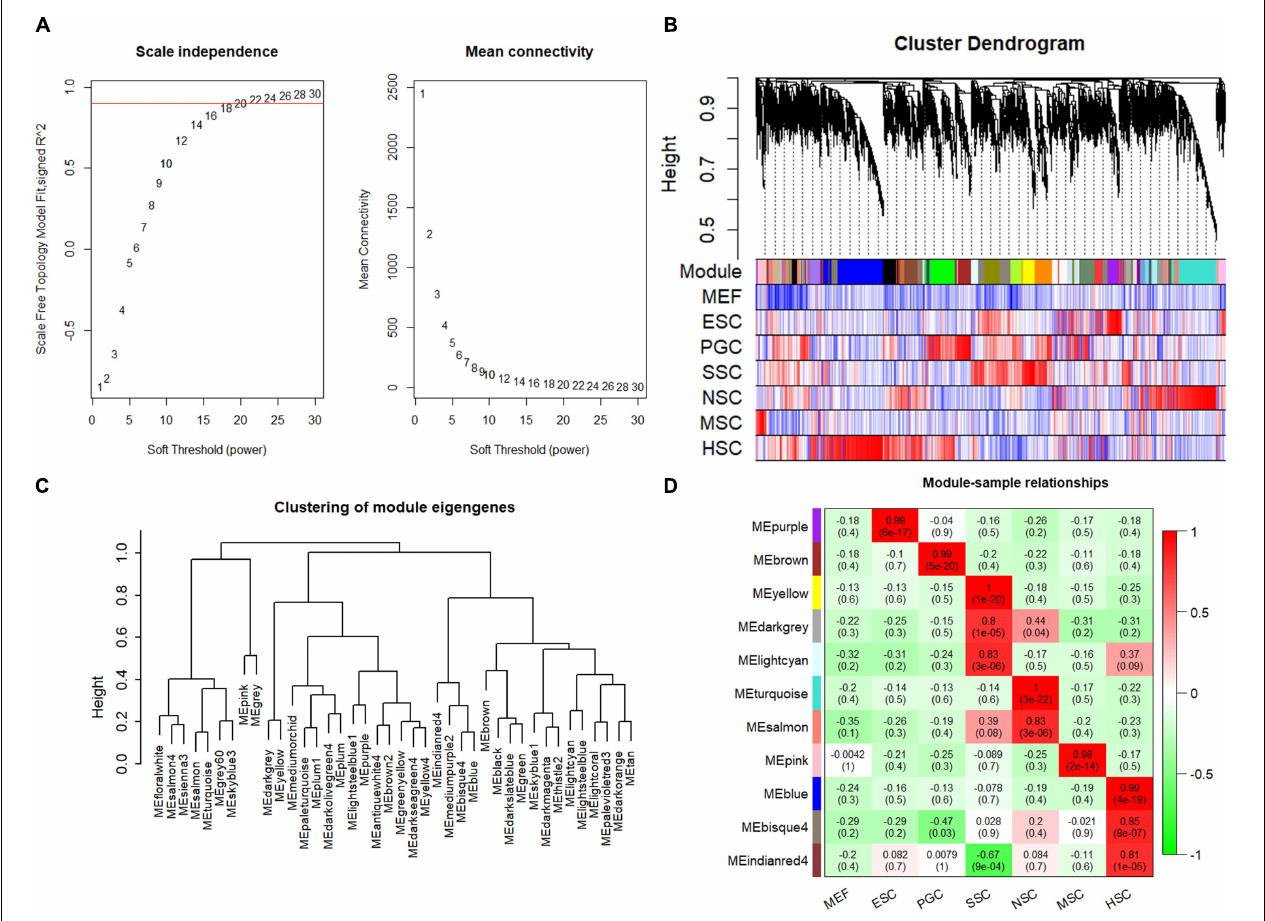
FIGURE 2 | WGCNA identified stem cell type-specific highly expressed genes. (A) Selection of soft thresholding powers for WGCNA. The red line corresponds to 0.9. As the lowest power that satisfies the approximate scale-free topology criterion, the number 20 was interpreted as a soft-threshold of the correlation matrix. (B) Heat map of the gene dendrogram that was assigned to the six different subtypes of stem cells. The colored row indicates the expression values of genes in the dendrogram. (C) The identified module eigengenes were classified into three groups by hierarchical clustering. (D) Heat map of the six different subtypes of stem cell-specific modules. Modules with a correlation of > 0.80 ( p < 0.01) were designated as stem cell-specific modules. Each row and column corresponded to the identified module and stem cell type. The correlations and p -values of the corresponding modules were